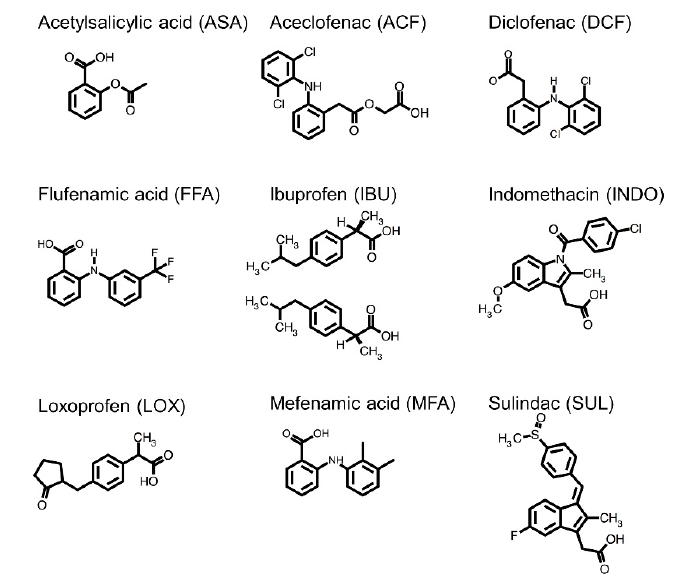
Figure 2. Chemical structures of non-steroidal anti-inflammatory drugs (NSAIDs) and their abbreviations: acetylsalicylic acid (ASA), aceclofenac (ACF), diclofenac (DCF), flufenamic acid (FFA), ibuprofen (IBU), indomethacin (INDO), loxoprofen (LOX), mefenamic acid (MFA), and sulindac (SUL).